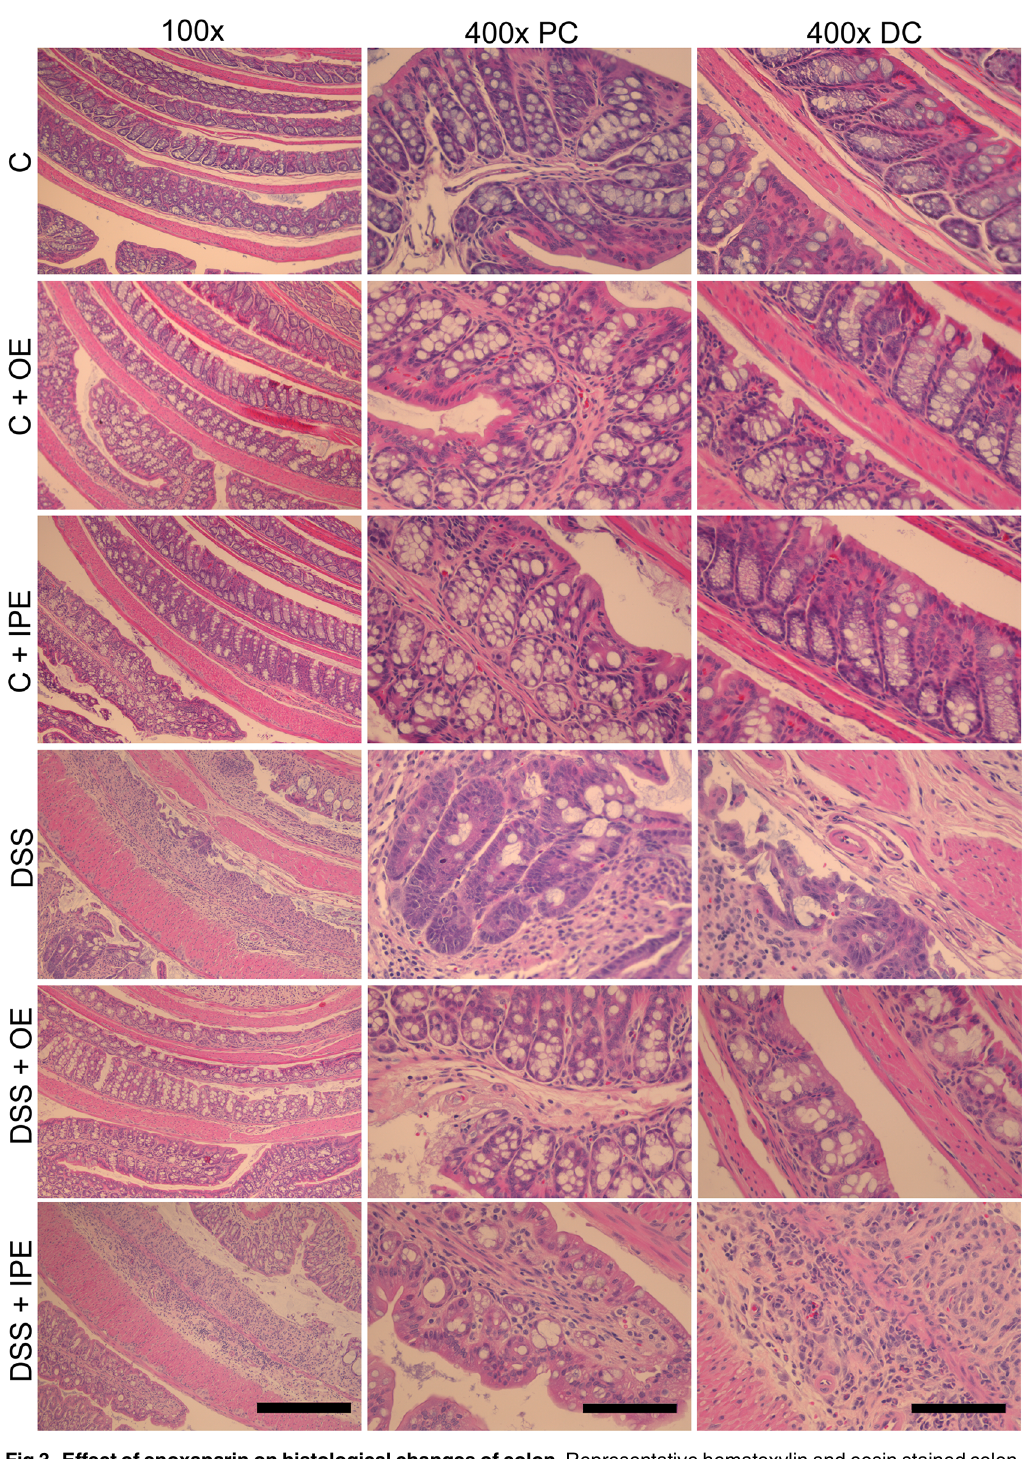
Fig 3. Effect of enoxaparin on histological changes of colon. Representative hematoxylin and eosin stained colon sections of healthy and colitis mice with and without enoxaparin. Scale bars = 100 μ m for 400 × and 400 μ m for 100 × magnification. Control, C; control with oral enoxaparin, C+OE; control with intraperitoneal injection of enoxaparin, C+IPE; untreated colitis, DSS; colitis with oral enoxaparin, DSS+OE; colitis with intraperitoneal injection of enoxaparin, DSS+IPE.